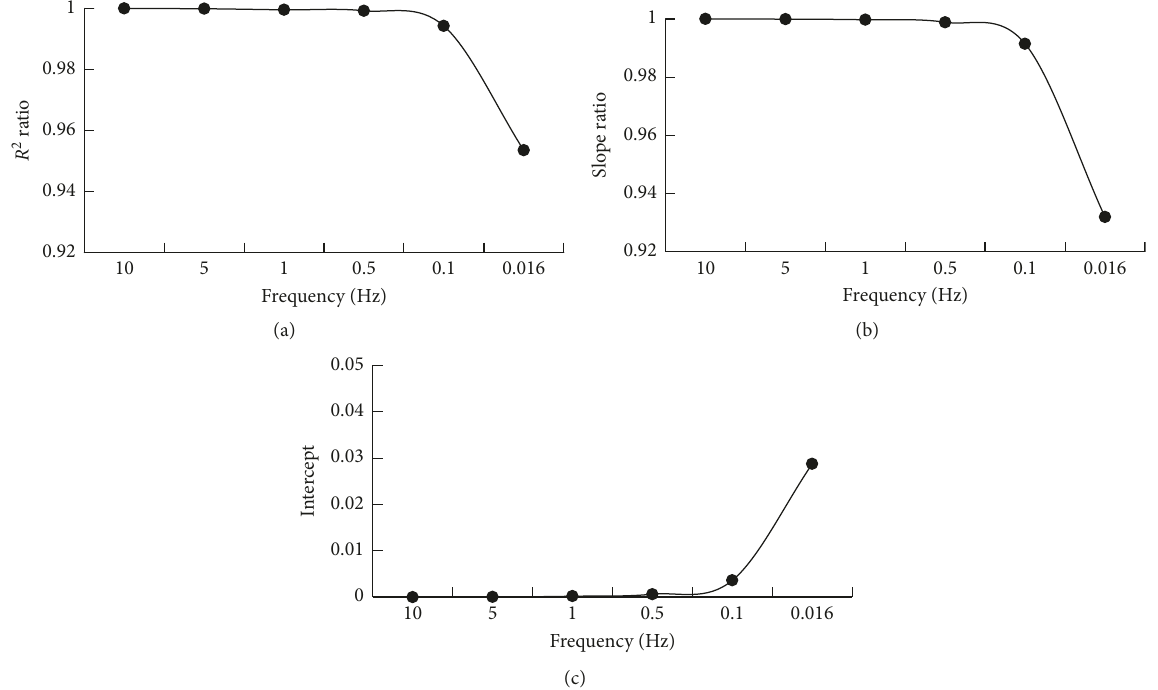
Figure 7: Ratio between the regression R 2 , slope, and the difference between intercept, between H frequency to those obtained at 10Hz. (a) Coefficient of determination; (b) slope; (c) Y -axis intercept difference.